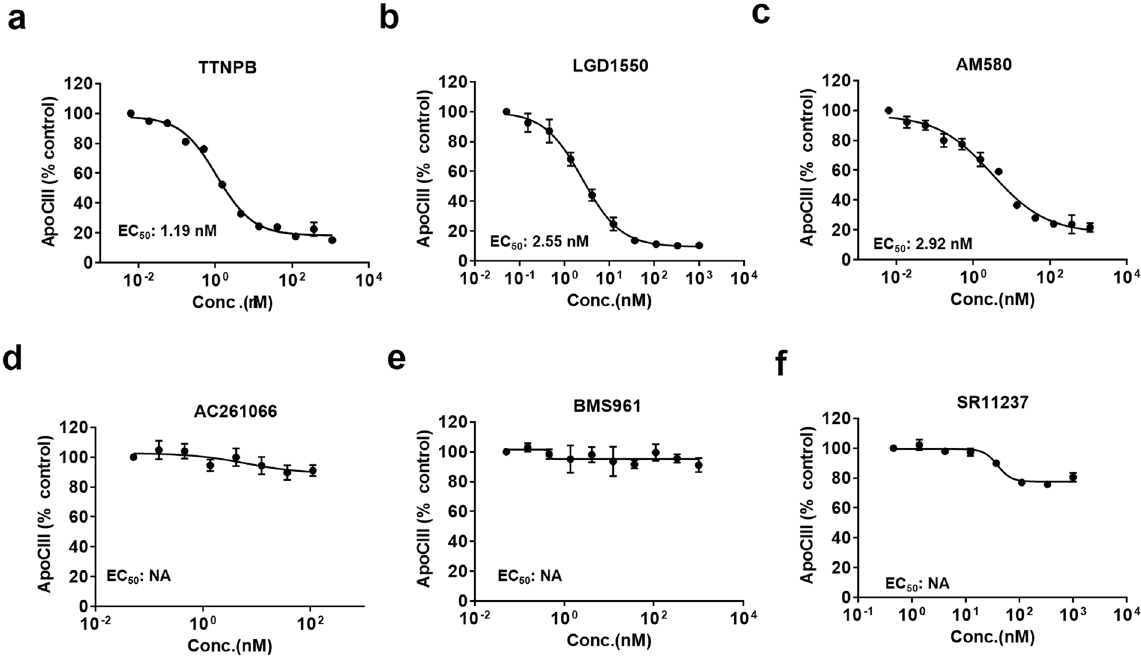
Figure 2. Effect of specific RAR α activation on ApoC-III secretion. Hep3B cells were stimulated with the indicated RAR agonist for 3 days and secreted ApoC-III protein levels were measured by an ApoC-III HTRF assay: ( a ) TTNPB, RAR pan-agonist. ( b ) LGD1550, RAR pan-agonist. ( c ) AM580, RAR α agonist. ( d ) AC21066, RAR β agonist. ( e ) BMS961, RAR γ agonist. ( f ) SR11237, RXR agonist. Representative triplicate data is shown from at least three independent